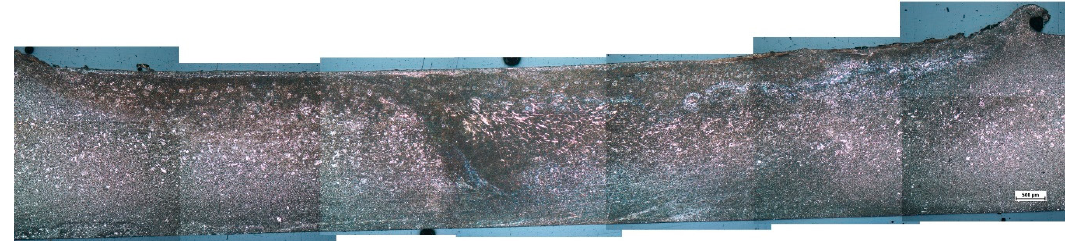
Figure 1. Transversal section of high pressure die casting (HPDC) of AZ91 plate after friction stir processing (FSP) at 2500 rpm and 30 mm/min, showing the nugget zone (the marker length is 500 µm).